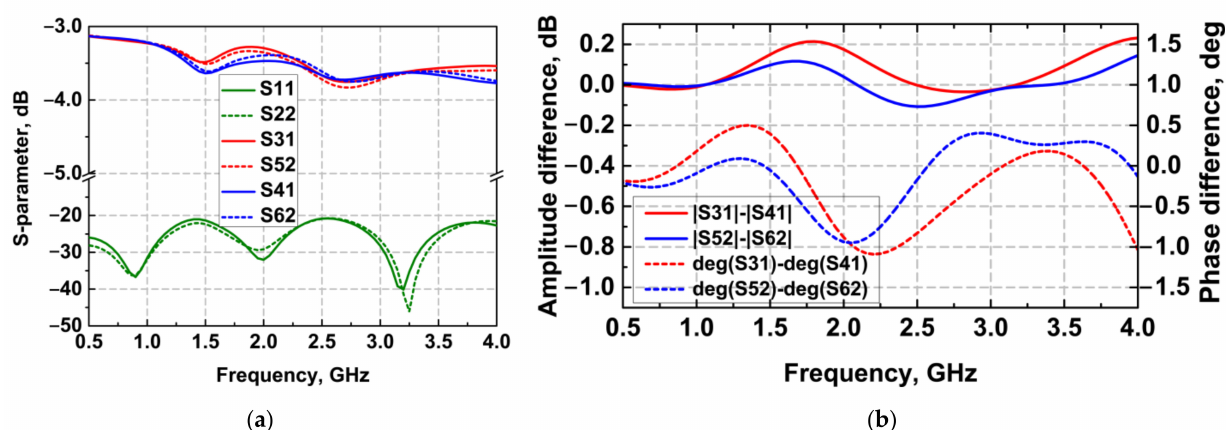
Figure 6. The performance of the balun-divider structure. ( a ) The reflection coefficients of the input ports and insertion losses from input ports to output ports; ( b ) the amplitude imbalance and phase imbalance between the output ports. Table 1. The parameters of the proposed antenna. Params.